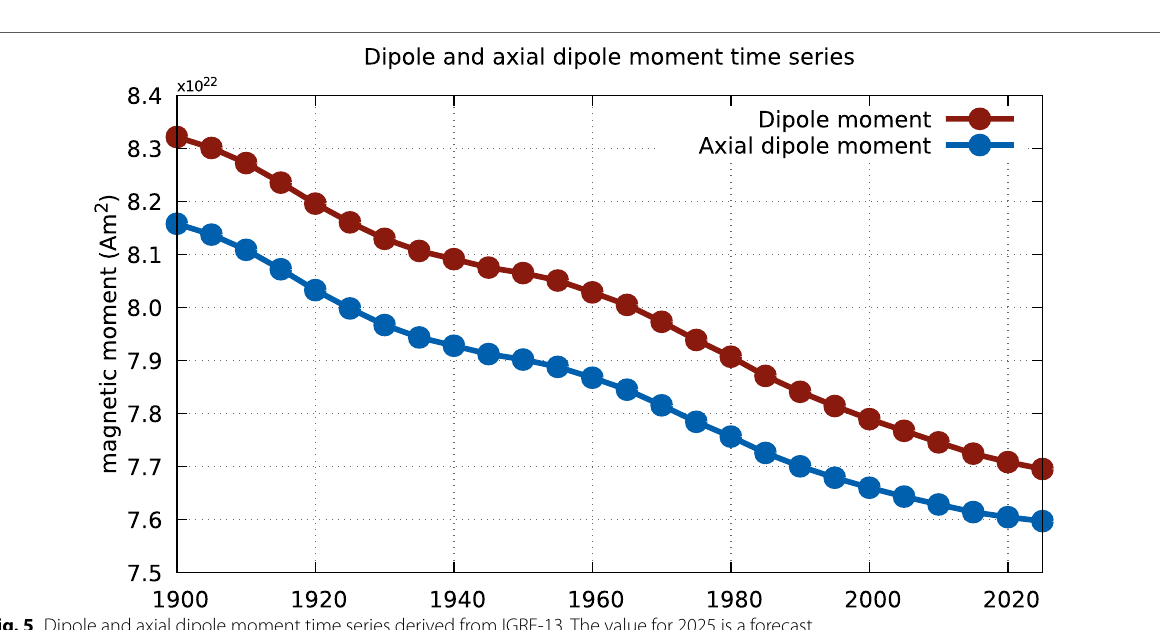
ce/model s_compa ss/igrf_calc.html and http://wdc.kugi.